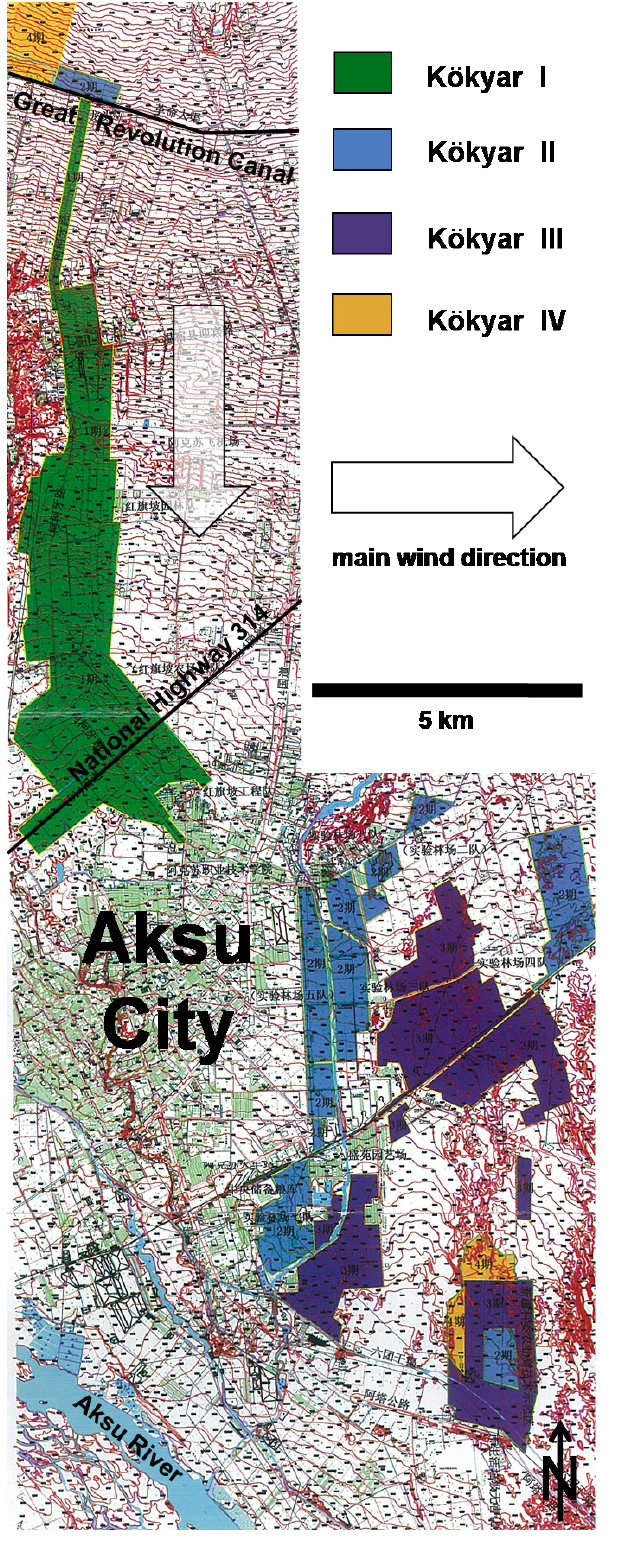
Figure 2. The project areas of Kökyar I, II, III and IV (partial view; adapted from Kökyar Annals Compilation Committee,